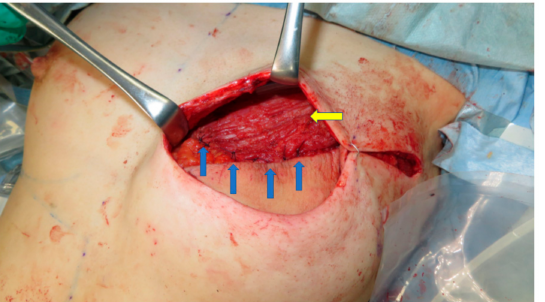
Figure 5. The caudal edge of the muscle roll (yellow arrow) is sutured to the cephalad edge of the PAP flap to reconstruct a smooth plane (blue arrows).